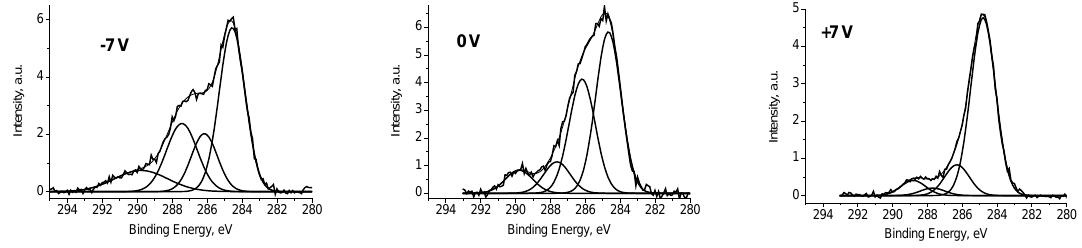
Figure 6. The C 1s and O 1s photoelectron spectra of Ag black measured at different U b = +7 (1), − 7 (2), 0 V (3).